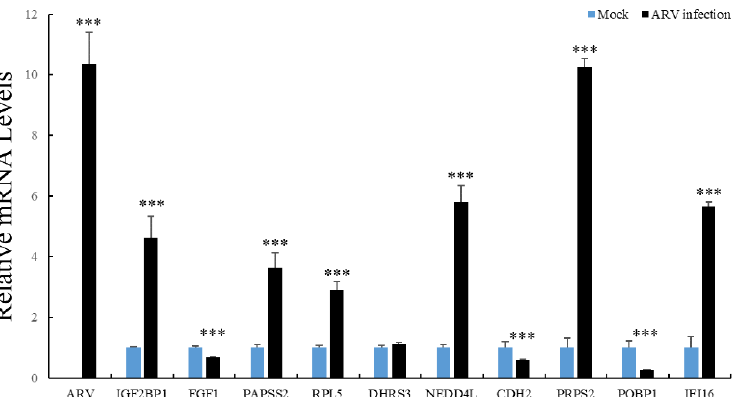
Figure 6. Detection of the mRNA expression of the identified protein interacting with ARV p17 after ARV infection for 12 h by qRT-PCR. Data were pooled across experiments and analyzed using t tests. Bars indicate the grand means ± standard deviation (SD). ***, p < 0.001.